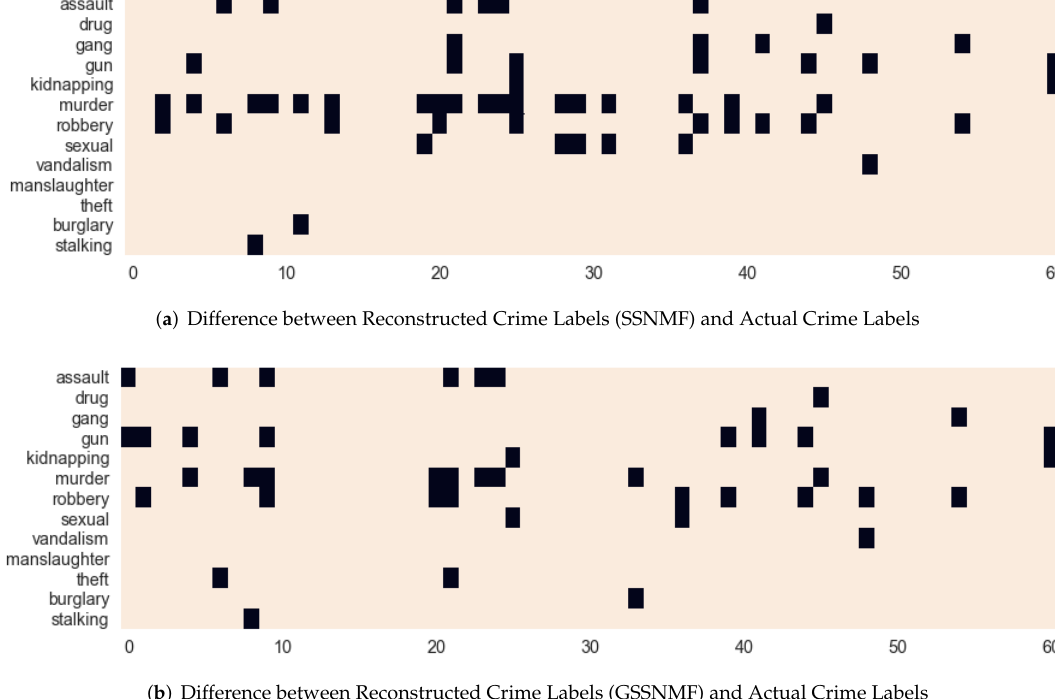
Figure 3. Difference between Reconstructed Labels using SSNMF and GSSNMF and Actual Crime Label matrices ( µ = 0.0011, λ = 0.0007), a light pixel indicates correct label assignment, while a dark pixel indicates